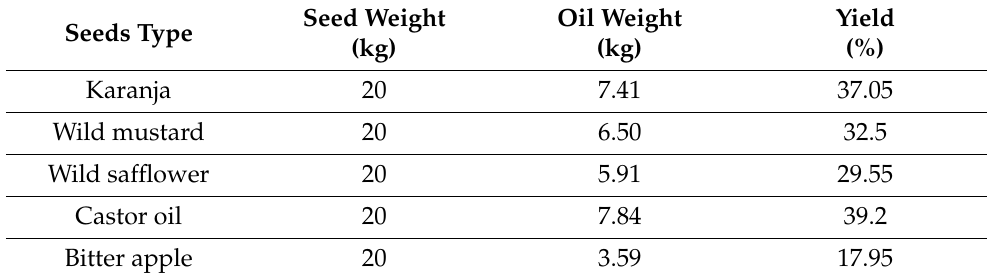
Table 1. Percentage oil yield of five different